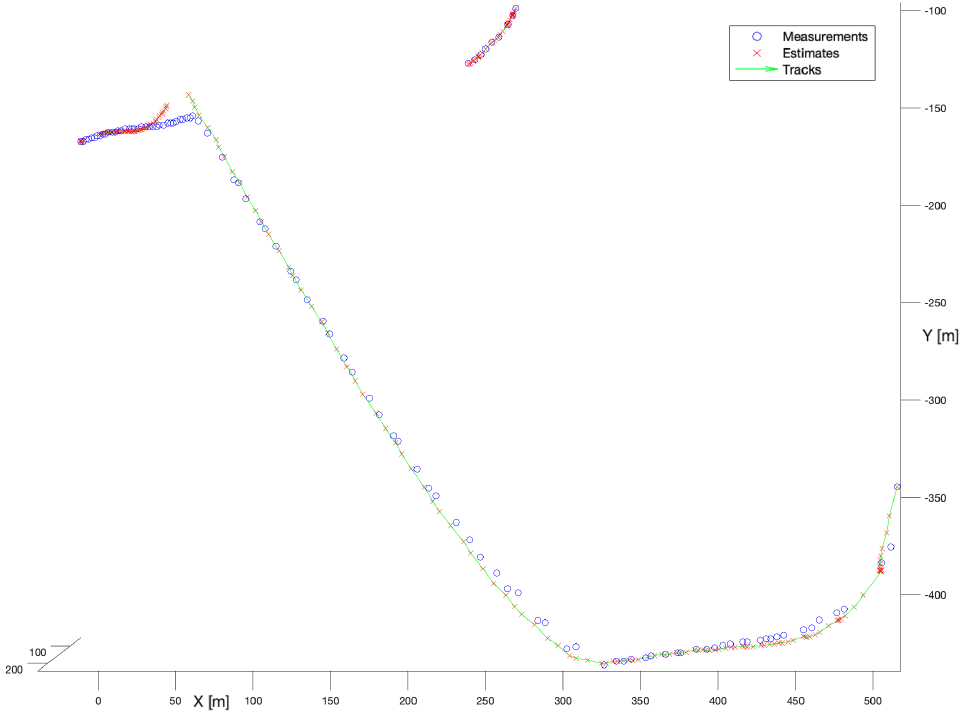
Figure 11. Multiple tracks Interacting Multiple Model. Multiple bird flight scenario.